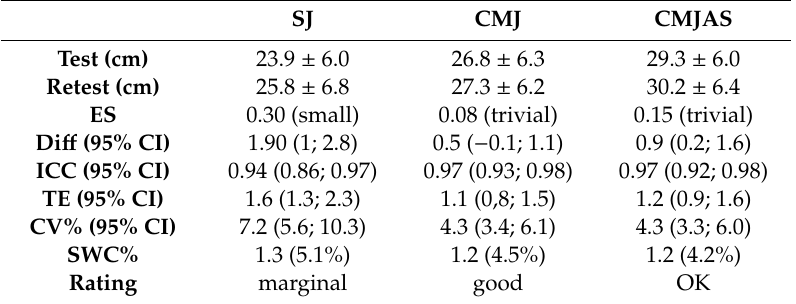
Table 3. Test-retest reliability and usefulness of My Jump 2 in female recreationally active adults.